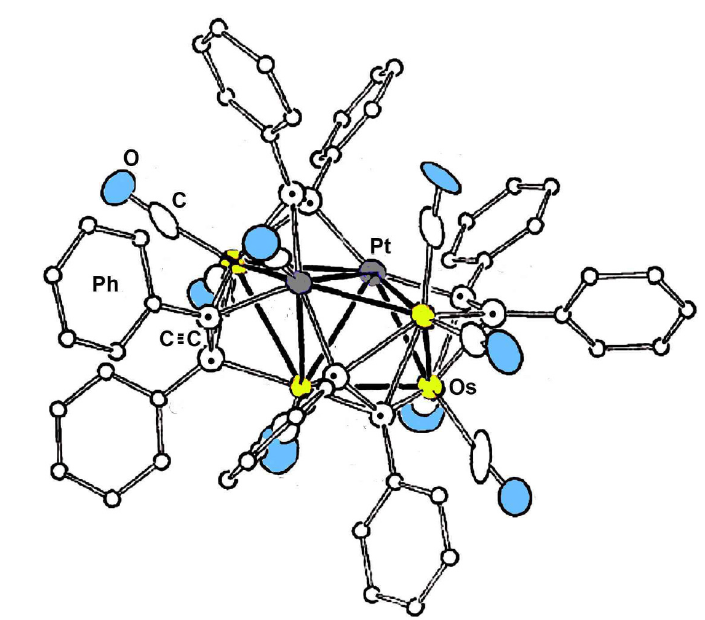
Figure 6. Structure of [(CO)Pt